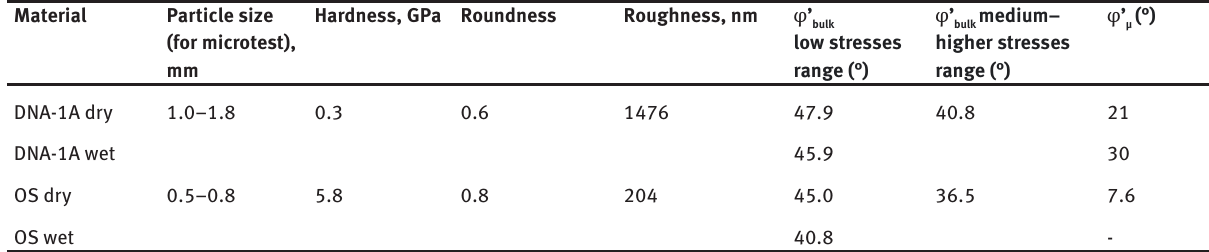
Table 2: Morphological and friction parameters for two granular soils (DNA-1A and OS) with different roughness, under both dry and wet conditions; the interparticle friction angle is assessed based only on tests carried out at 1 N normal contact force (data from Marzulli et al.